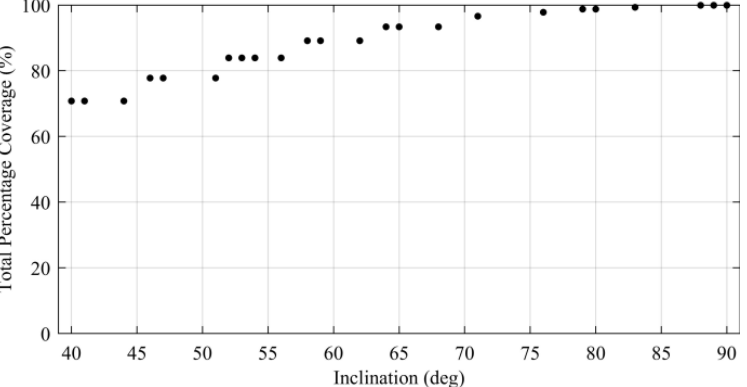
Figure 7. Relationship between inclination and total coverage in the optimal solution.